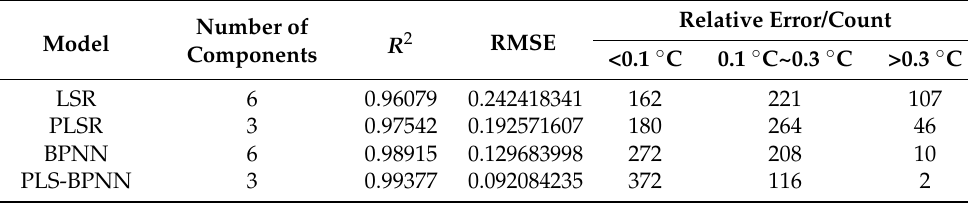
Table 2. Statistical table of fitting effect of each